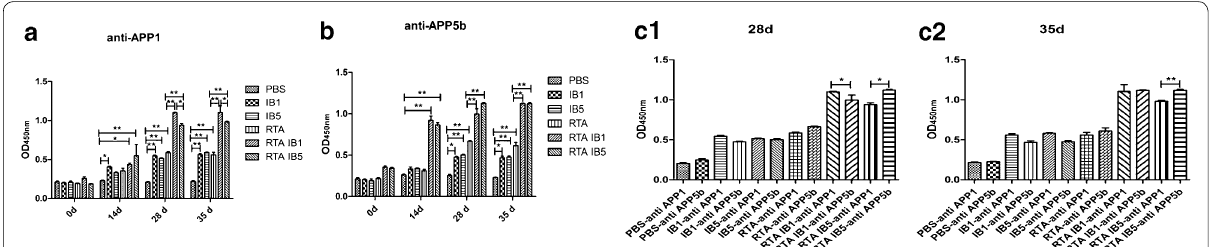
Fig. 3 The serum antibody level of the mice in all groups was detected by indirect ELISA. Each group had 6 mice. a APP1 was used as the coating antigen. b APP5b was used as the coating antigen. c1 At day 28 of immunization, the antibody level of the mice in all groups was detected by indirect ELISA. c2 At day 35 of immunization, the antibody level of the mice in all groups was detected by indirect